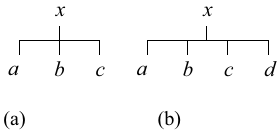
Fig. 3 CPM a Swallow tail catastrophe model; b Butterfly catastro- phe model